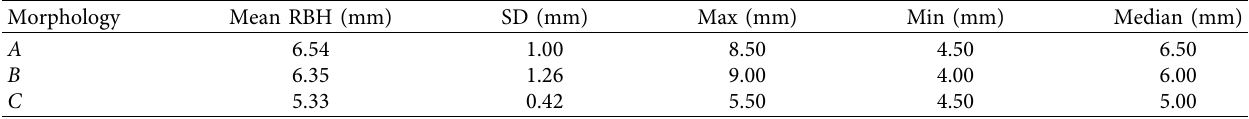
Table 4: The RBH values were compared between different morphological classifications based on the coronal plane. Morphology